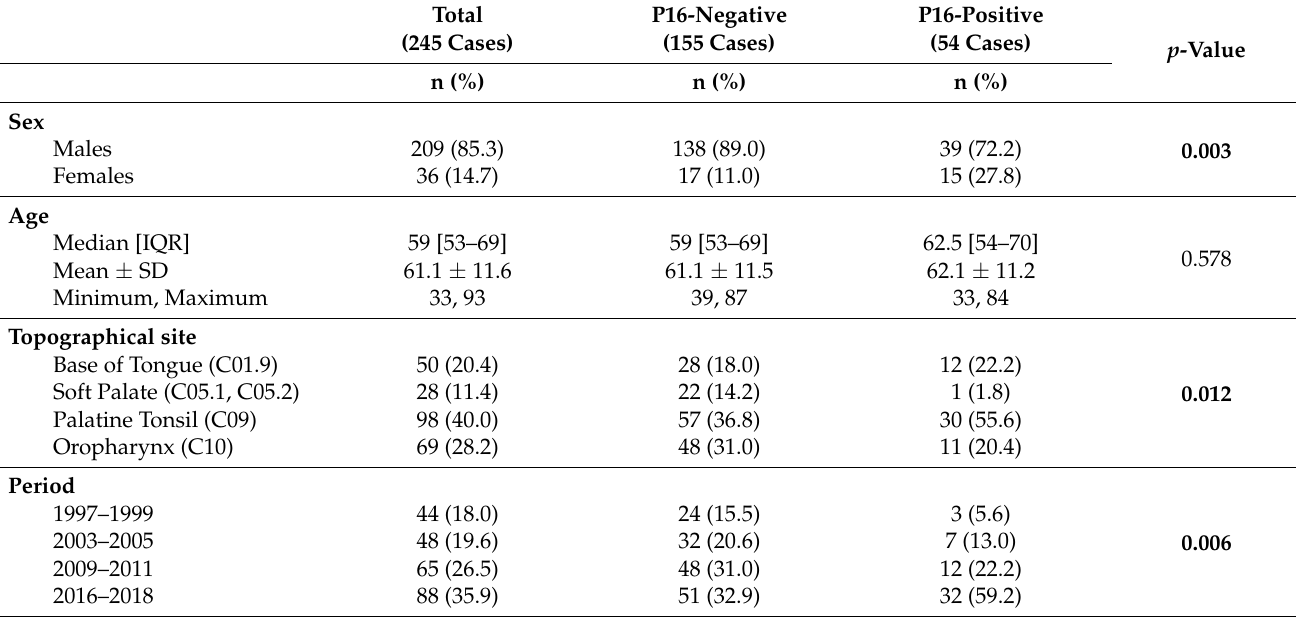
Table 3. Characteristics of cases included in the p16 expression-based